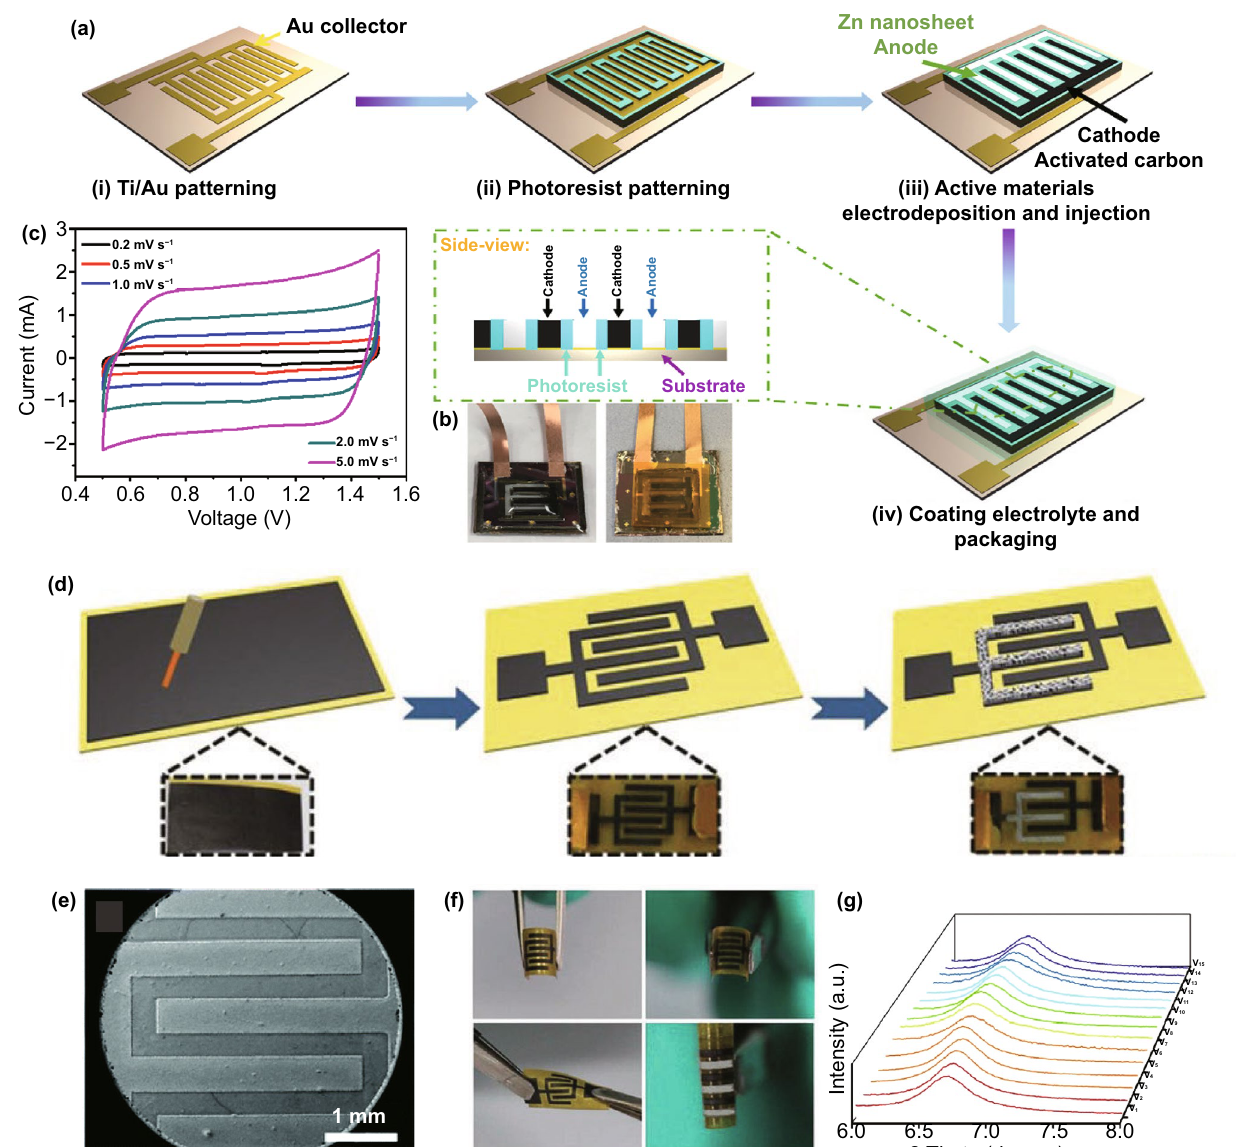
Fig. 12 a Fabrication process, b optical images before and after packaging and c CV curves of the Zn//AC ZmSCs. Reproduced with permis‑ sion from Ref. [32]. Copyright 2019, Wiley–VCH. d Preparation processes of the Zn//CNT ZmSCs. e SEM image of microelectrode. f Pho‑ tographs of the Zn//CNT ZmSCs at the bent and twisted states. Reproduced with permission from Ref. [97]. Copyright 2018, Royal Society of Chemistry. g Ex‑situ XRD spectra of Ti 3 C 2 T x cathode in ZmSCs. Reproduced with permission from Ref. [153]. Copyright 2021, Springer